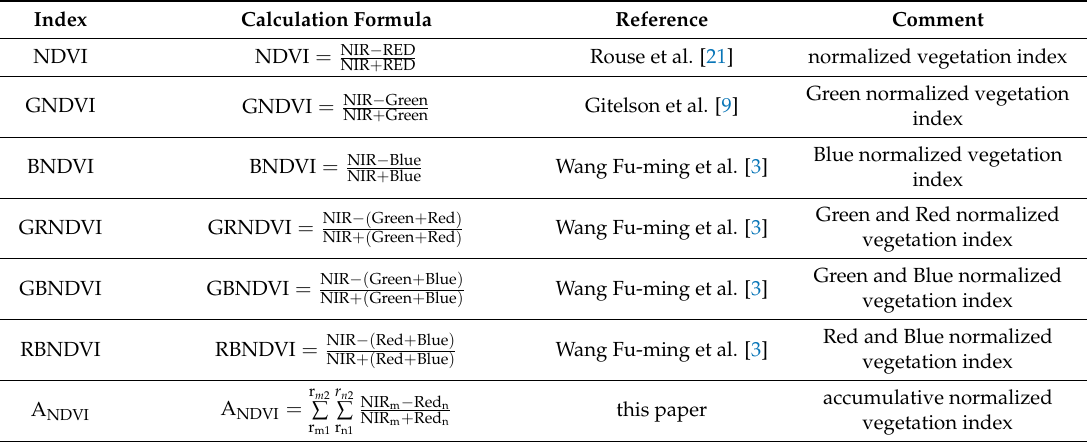
Table 1. Summary of NDVI and its derivative